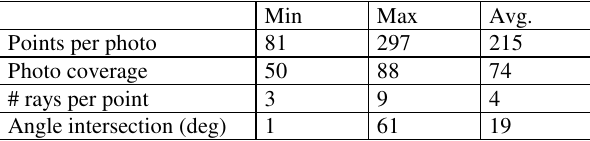
Table 12 – Campidoglio: block strength